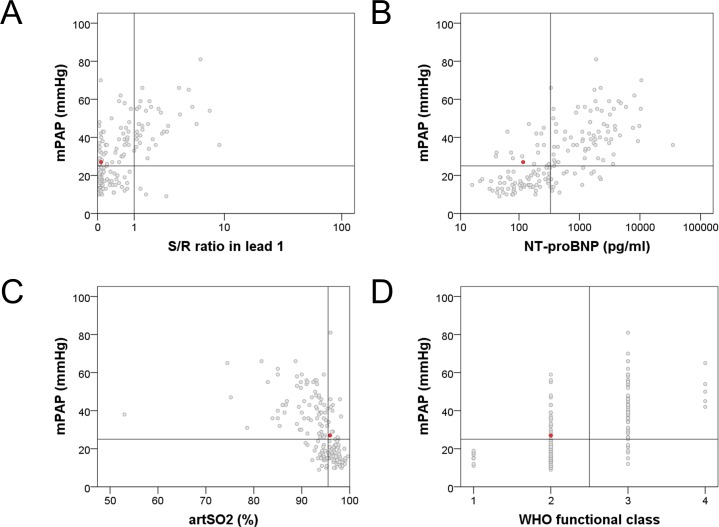
A-D. Associations between the simple non-invasive parameters and mean pulmonary arterial pressure–data based on the analysis of the prospective cohort. The red dot represents the patient with pulmonary hypertension who was missed by the algorithm. (mPAP: mean pulmonary arterial pressure, NTproBNP: N-terminal pro brain natriuretic peptide, art SO2: arterial oxygen saturation).